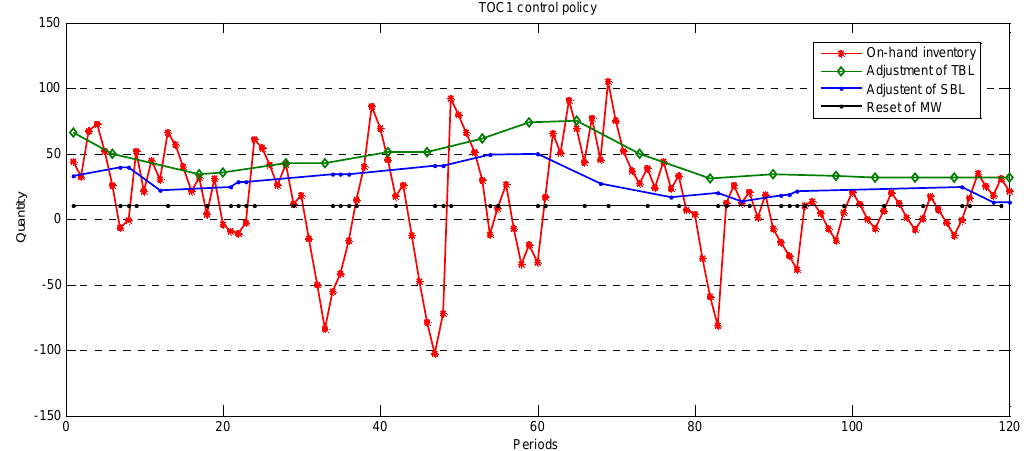
Fig.14. Inventory adjustment process under TOC1 control policy